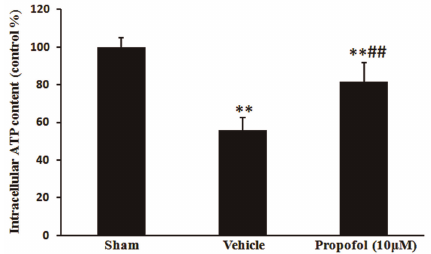
Figure 7. Effect of propofol on burn serum-induced loss of mitochondrial membrane potential ( Dy m ). Cells with depolarized mitochondria were significantly increased in the vehicle group compared with the sham group. Propofol pretreatment reduced the cells with depolarized mitochondria. RLMVECs: rat lung micro- vascular endothelial cells. Data are reported as means±SD (n=5 in each group). **P , 0.01, compared to the sham group; ## P , 0.01 compared to the vehicle group (one-way ANOVA).